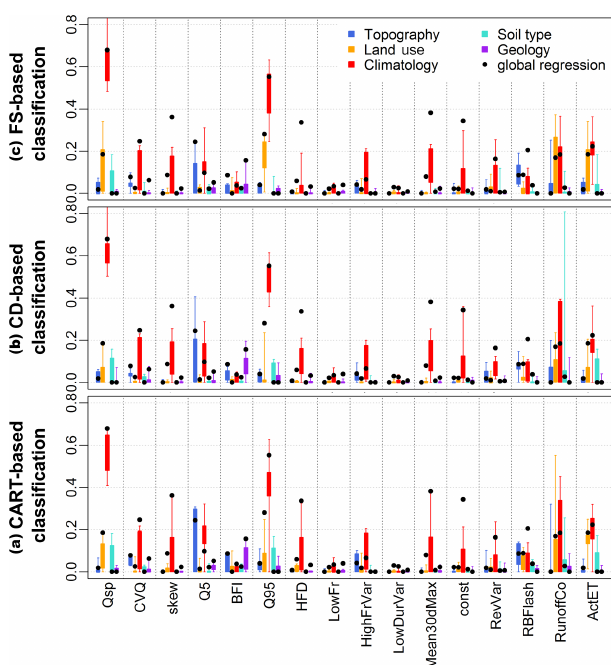
Figure 5. Partial R 2 of different types of descriptors (Table 1) used in the regression models for flow signatures (partial R 2 for the type of descriptors is the sum of partial R 2 of variables from that type used in the regression model). The boxplots show the range of val- ues among the models calibrated in the different classes using the different catchment classification methods: (a) flow signatures at flow gauges, (b) catchment descriptors, and (c) CART predictive re- gression trees. The black point gives the value for the general model calibrated over the whole